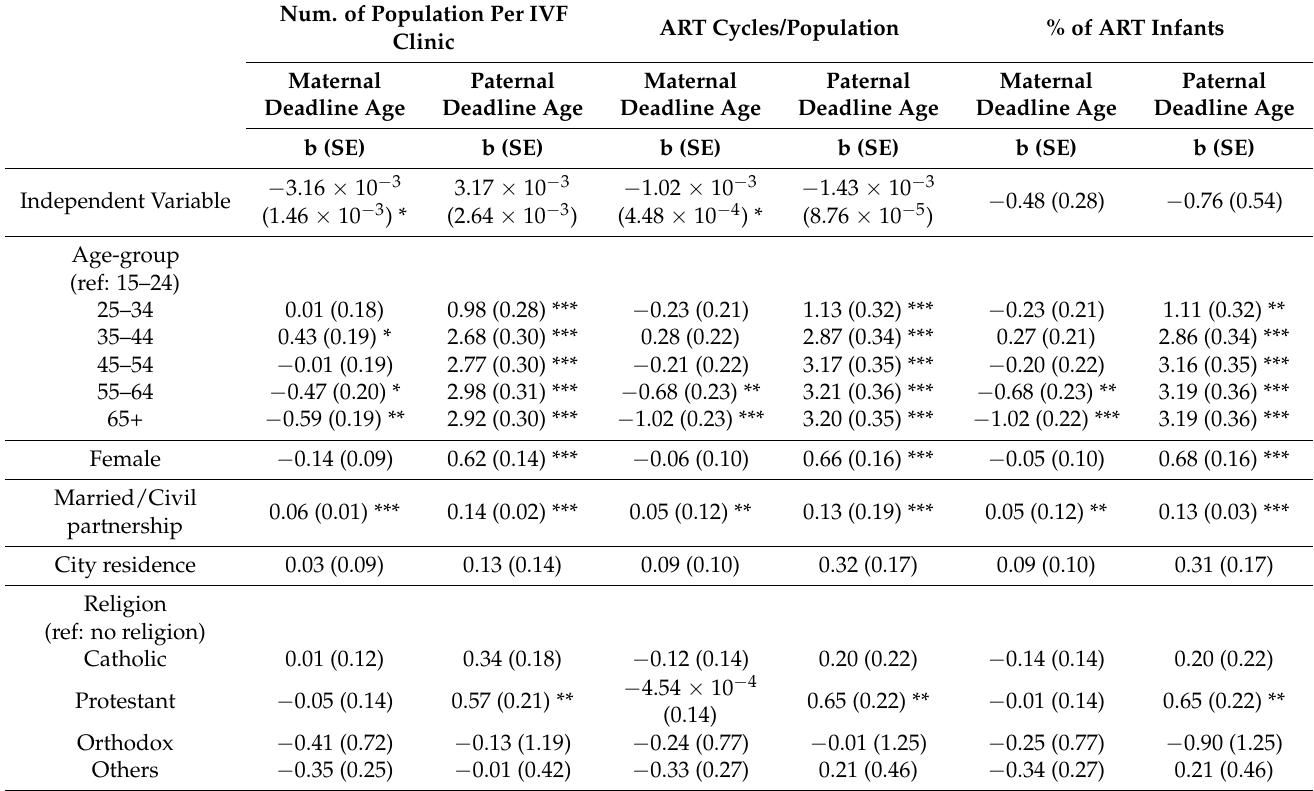
Table 4. Social perceptions of maternal and paternal deadline age for childbearing by countries. Num. of Population Per IVF ART Cycles/Population % of ART Clinic